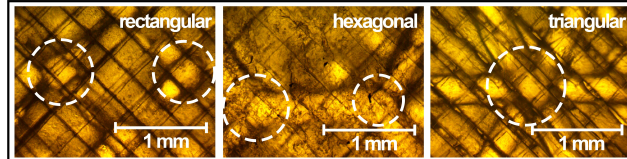
Figure 10. Comparison of relative permittivity between different infill patterns.